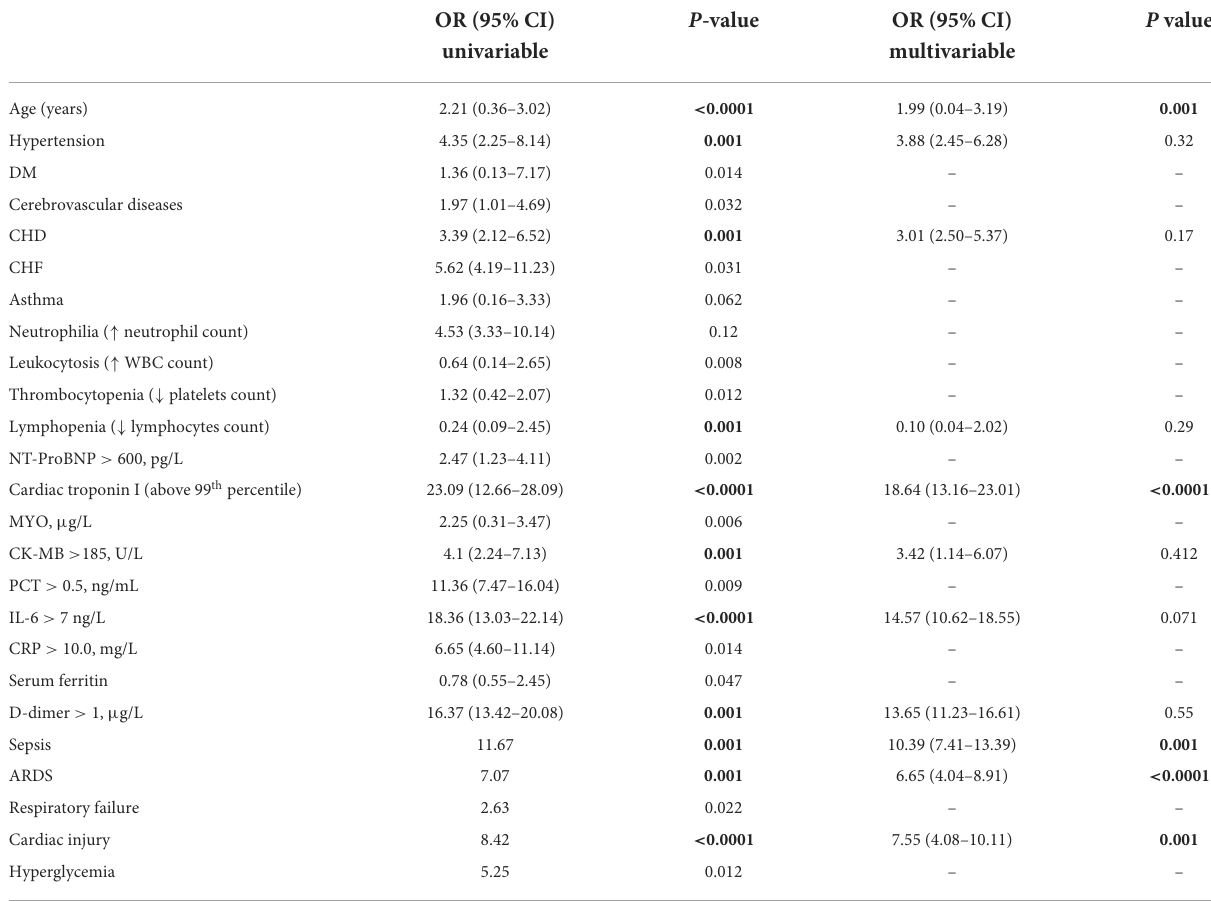
TABLE 4 Potential risk factors linked with in-hospital mortality of COVID-19